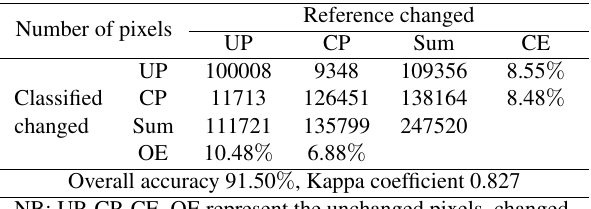
Figure 4: The posterior probability map for the China region: a) acquired on April 30, 2000, and b) acquired on April 10, 2010.